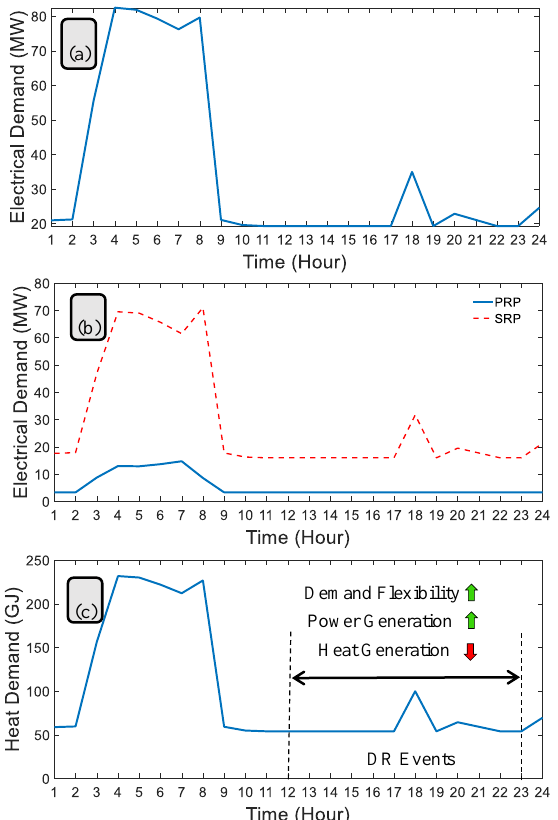
Figure 10. Optimized operation of the ORI in terms of ( a ) Total electricity demand ( b ) Electricity demand of two sub-processes and ( c ) Total heat demand.